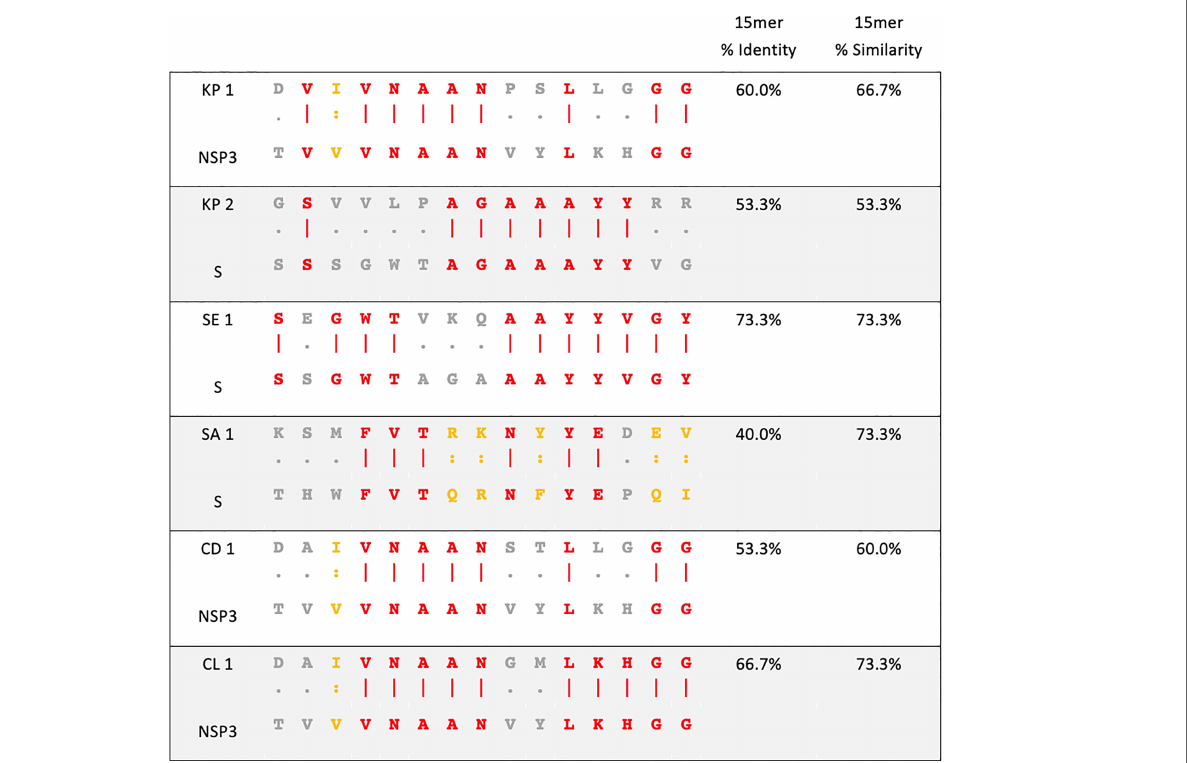
FIGURE 1 | Sequence homology between pathogenic bacteria and SARS-CoV-2. Amino acid sequence alignment of pathogenic bacteria (top) and SARS-CoV-2 (bottom) used in this study. KP- Klebsiella pneumoniae , SE- Salmonella Enteritidis, SA- Staphylococcus aureus , CD- Clostridioides dif fi cile , CL- Clostridium spp., NSP3- non-structural protein 3 of SARS-CoV-2, S- spike glycoprotein of SARS-CoV-2. Red amino acid- identity. Yellow amino acid- similarity. Grey amino acid- no identity or